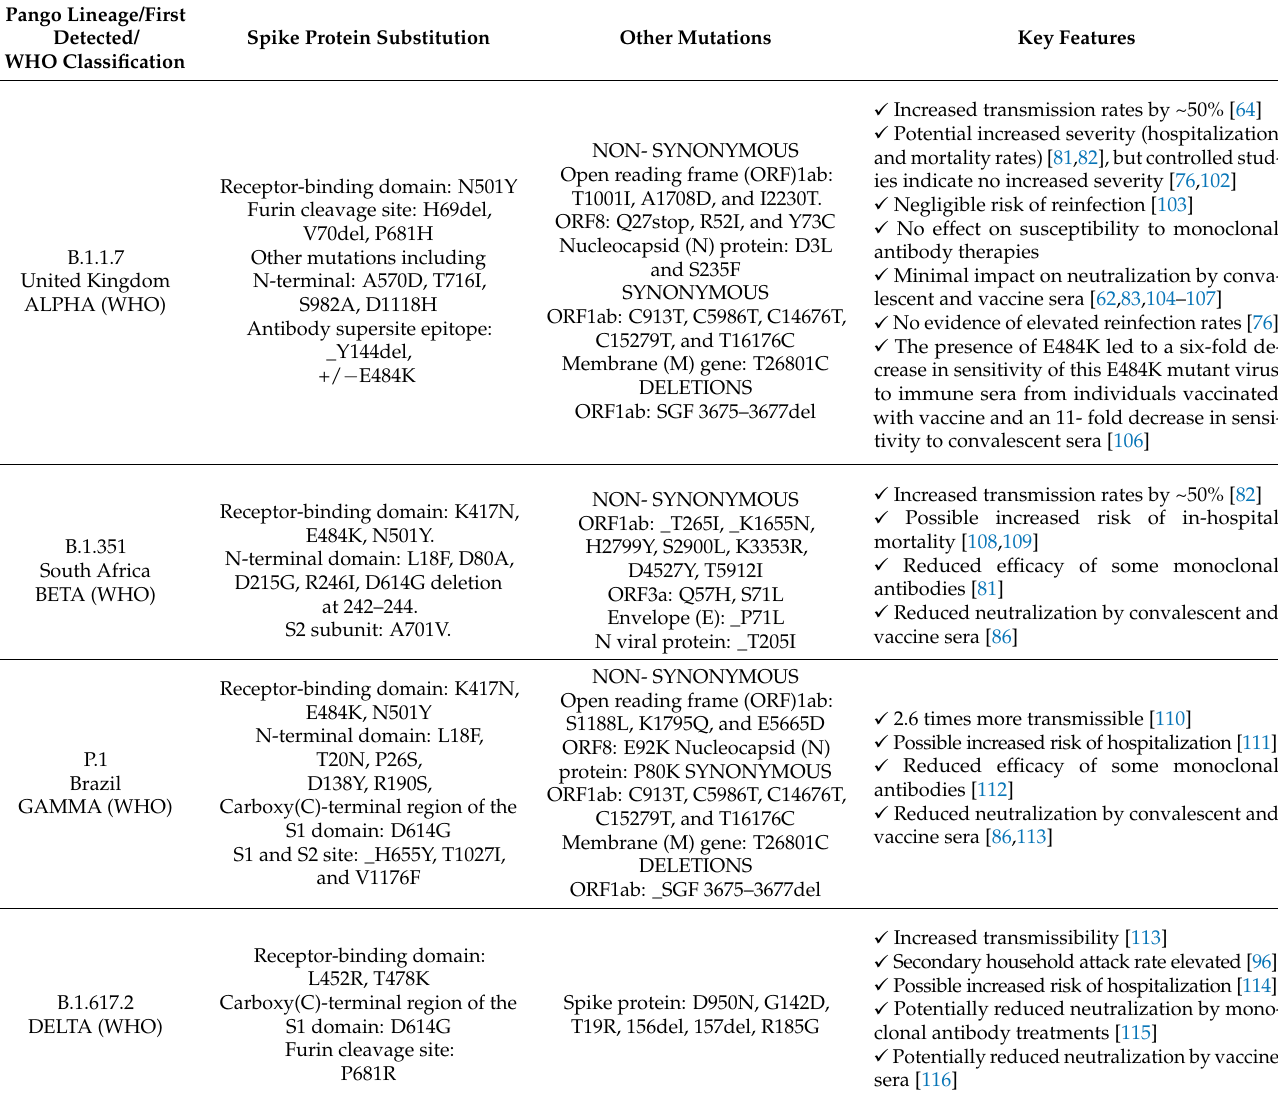
Table 2. Predominant Spike Mutations associated with SARS-CoV-2 variants.